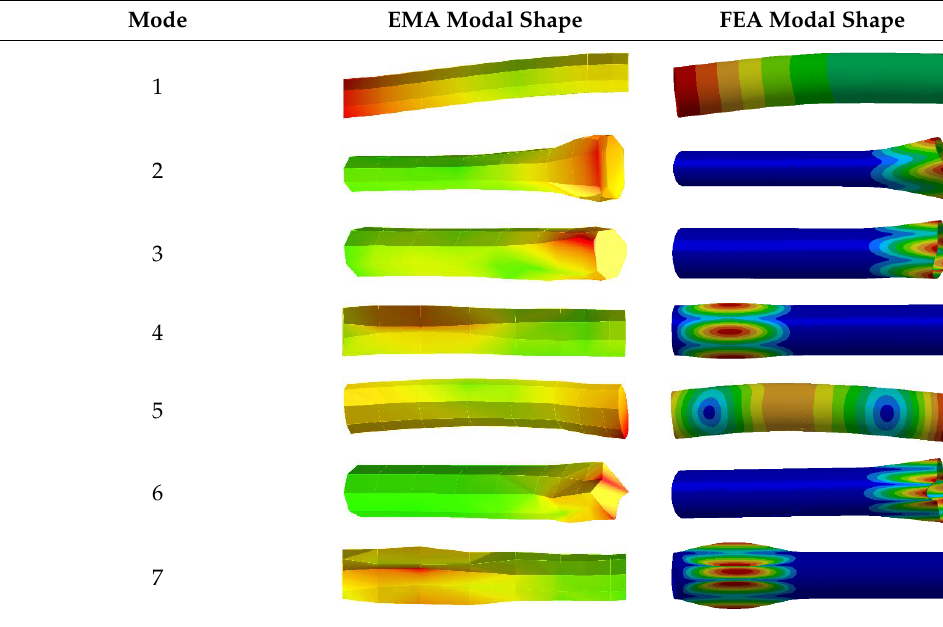
Table 5. Comparison table of modal shapes.